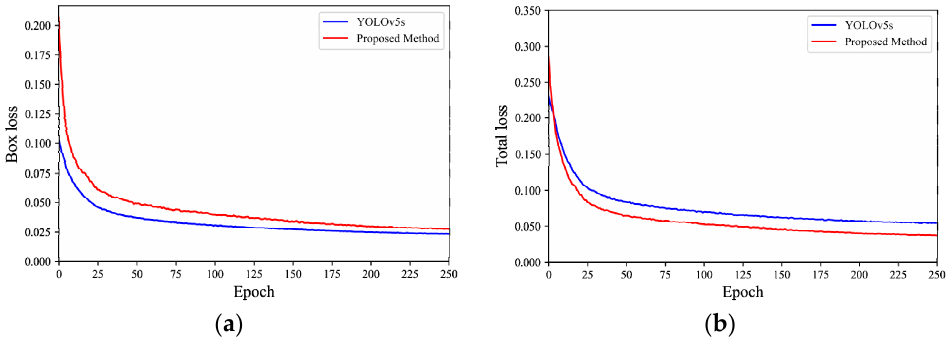
Figure 12. Loss curves. ( a ) Bounding box loss; ( b ) total loss.